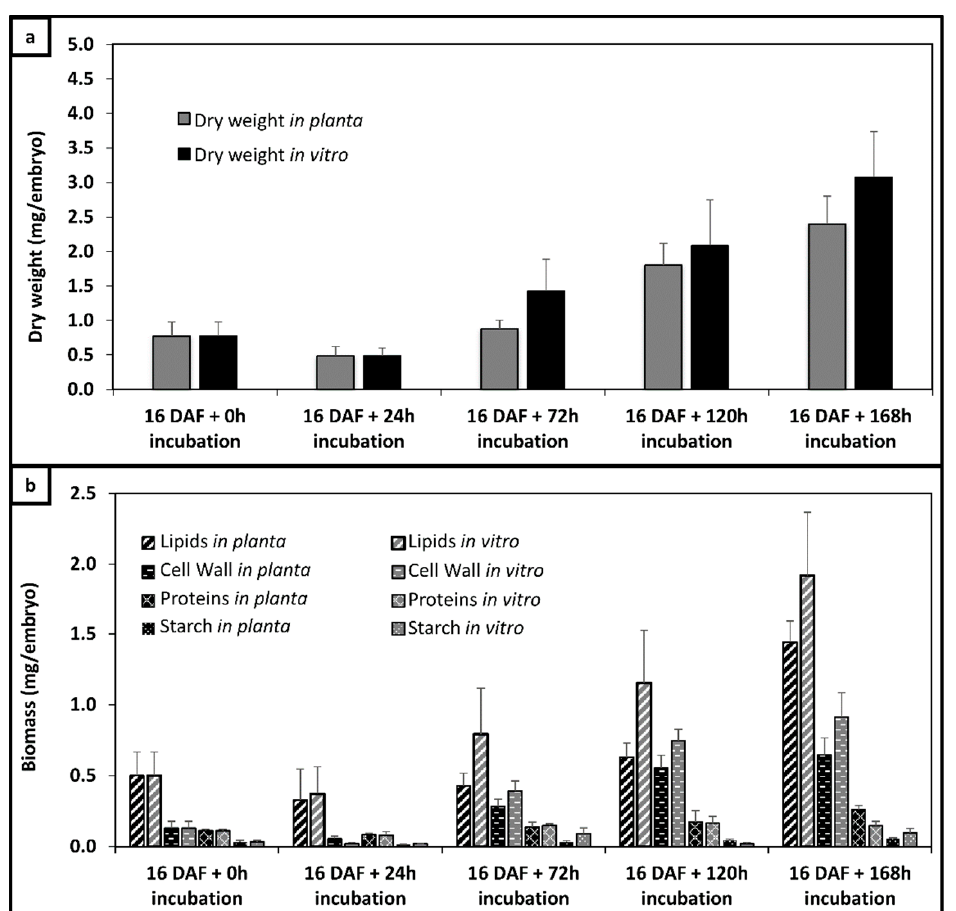
Figure 2. Weight and biomass composition between embryos cultured in vitro and the corresponding state in planta. ( a ) Dry weight between in planta and in vitro expressed in mg/embryo; ( b ) biomass accumulation between in vitro and in planta expressed in mg/embryo. Dry weight and biomass composition (lipids, proteins, cell wall and starch) content were determined as described in the “Materials and Methods” section from flax embryos cultivated from 16 days after flowering (DAF) for 24, 72, 120 and 168 h in culture medium A, containing unlabeled glucose and glutamine as the carbon source. For each kinetic point, four independent experiments were made.